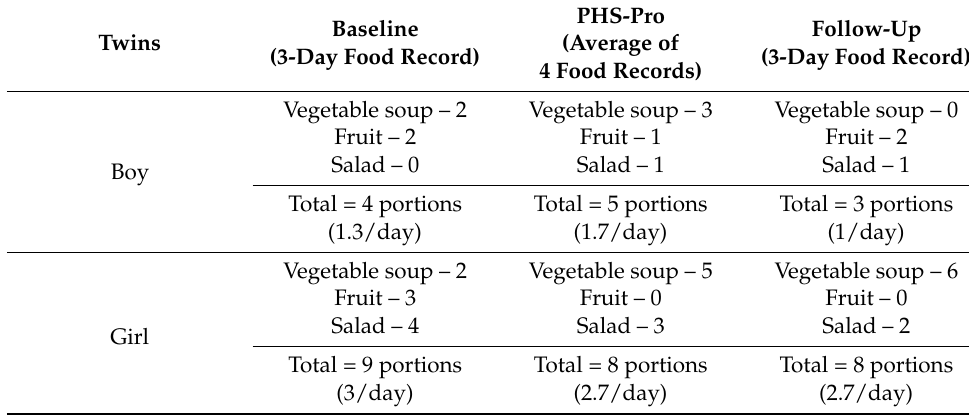
Table 1. Consumption of vegetable soup, fruit, and salad in the 3-day food record.